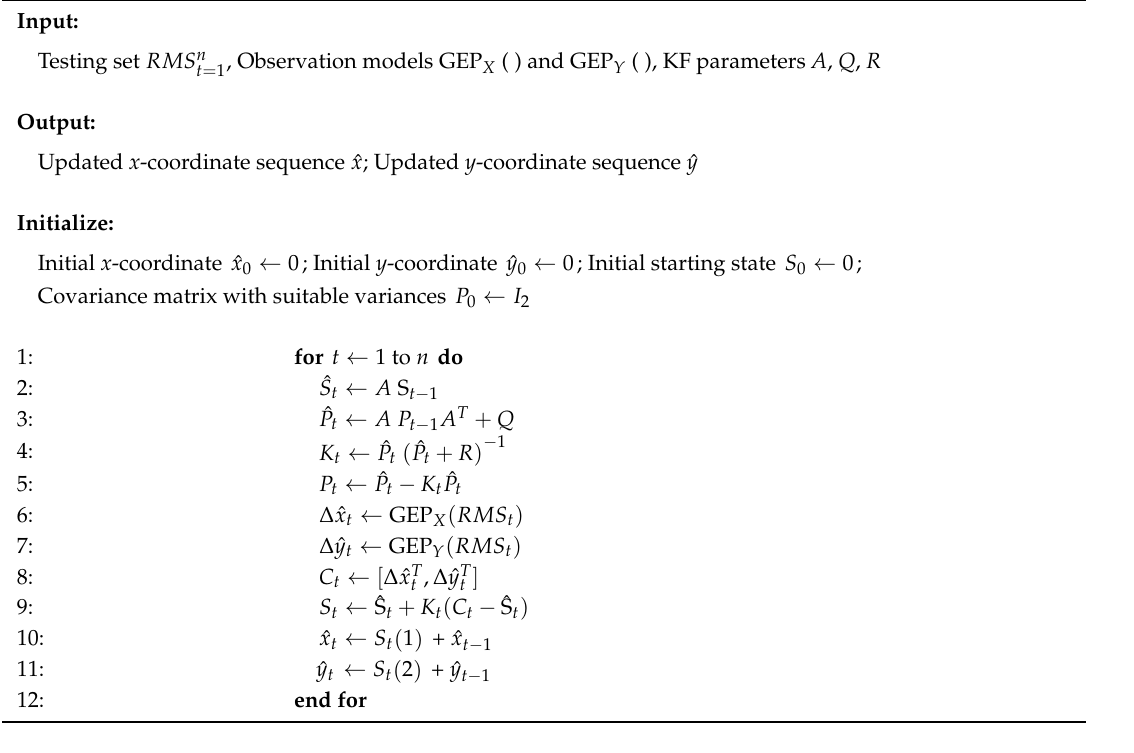
Algorithm 2 Continuous Coordinate